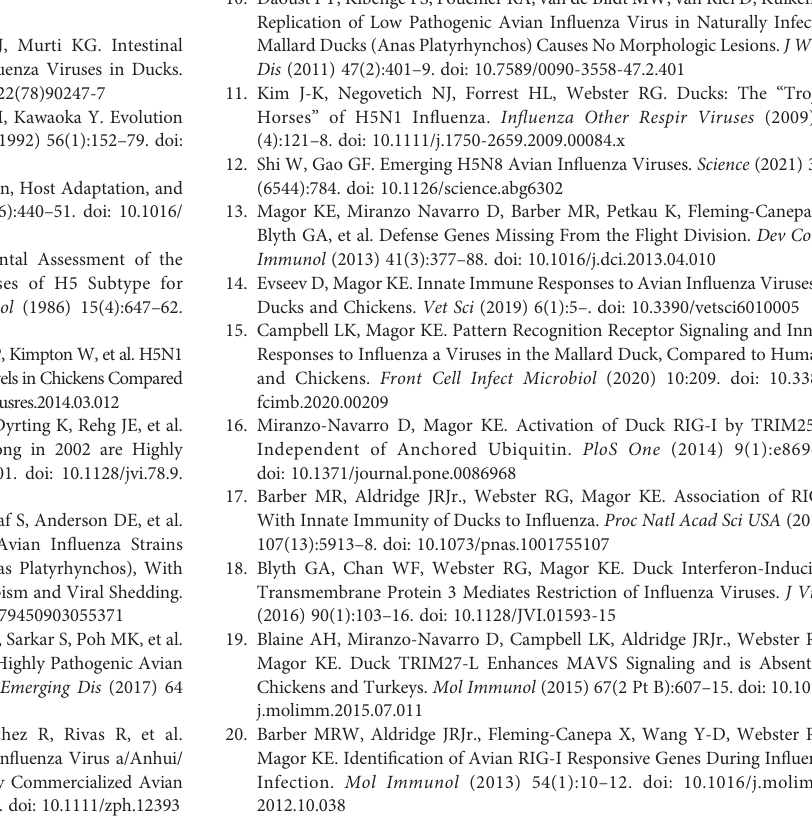
Supplementary Figure 1 | Gene ontology (GO) analysis of alternatively spliced genesinVN1203infectedducks.Statisticallysigni fi cant(FDR<0.05)alternativelyspliced genesweresubmittedtoenrichmentanalysisandthetop10mostenrichedtermsinthe category of GO biological process are graphed for lungs of ducks infected with VN1203 on 1 dpi (A) and lungs and spleens of ducks infected with VN1203 on 3 dpi (B) . Supplementary Figure 2 | Top100downregulated genes inlungs of VN1203and intestines of BC500 infected ducks. Lists of statistically signi fi cant (FDR<0.05) genes were fi ltered for the 100 genes most downregulated in lungs of VN1203 infected ducks on 1 dpi, and intestines of BC500 ducks on 2 dpi. Redundant genes, pseudo genes and genes denoted as ncRNA in NCBI were manually removed from